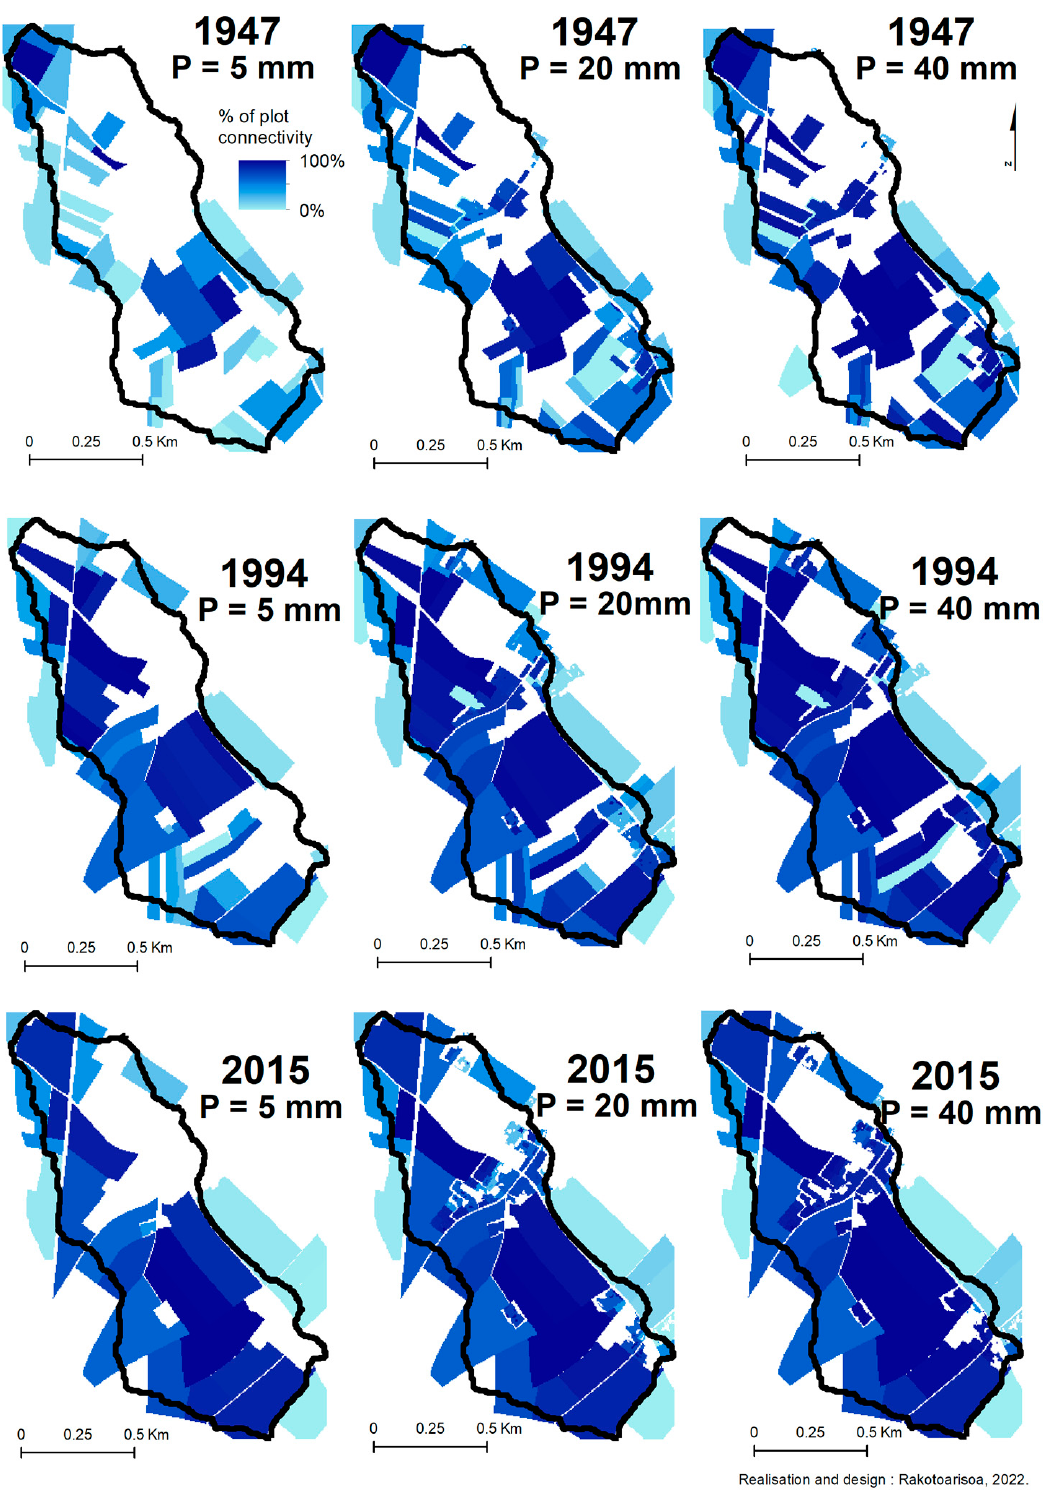
Figure 10. Effect of landscape structure and rainfall on the hydrological connectivity ( Ic v ) in the Glape basin. Table 1. Evolution of the connectivity indicator Ic s .